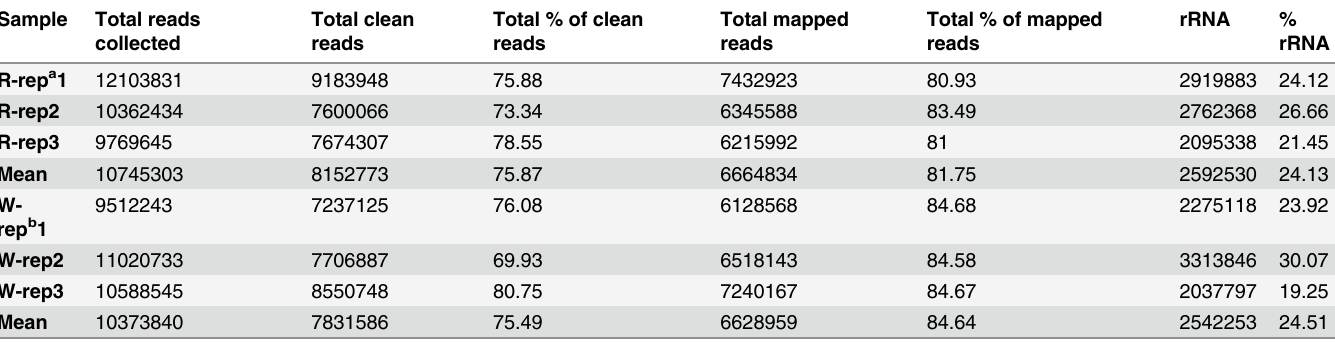
Table 1. Summary of RNA-Seq data in the red- and white-fleshed apple libraries.